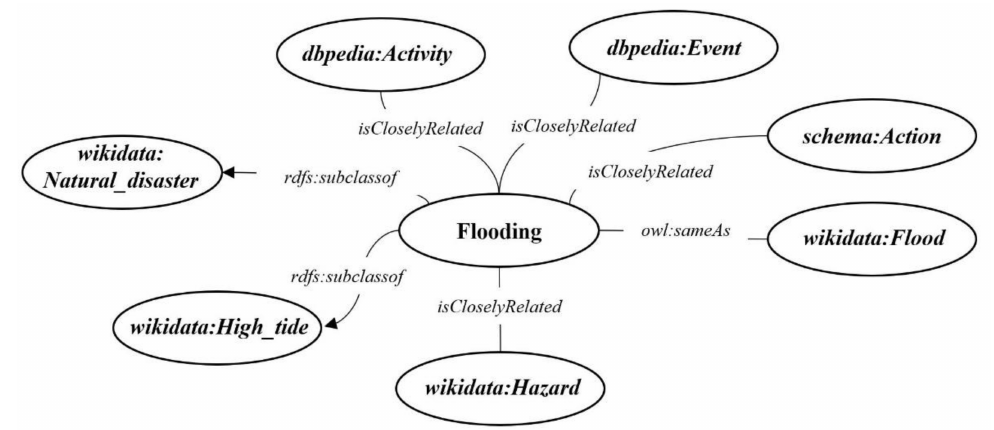
Figure 2. Hierarchical skeleton structure between the Flooding concept and the existing knowledge graph and